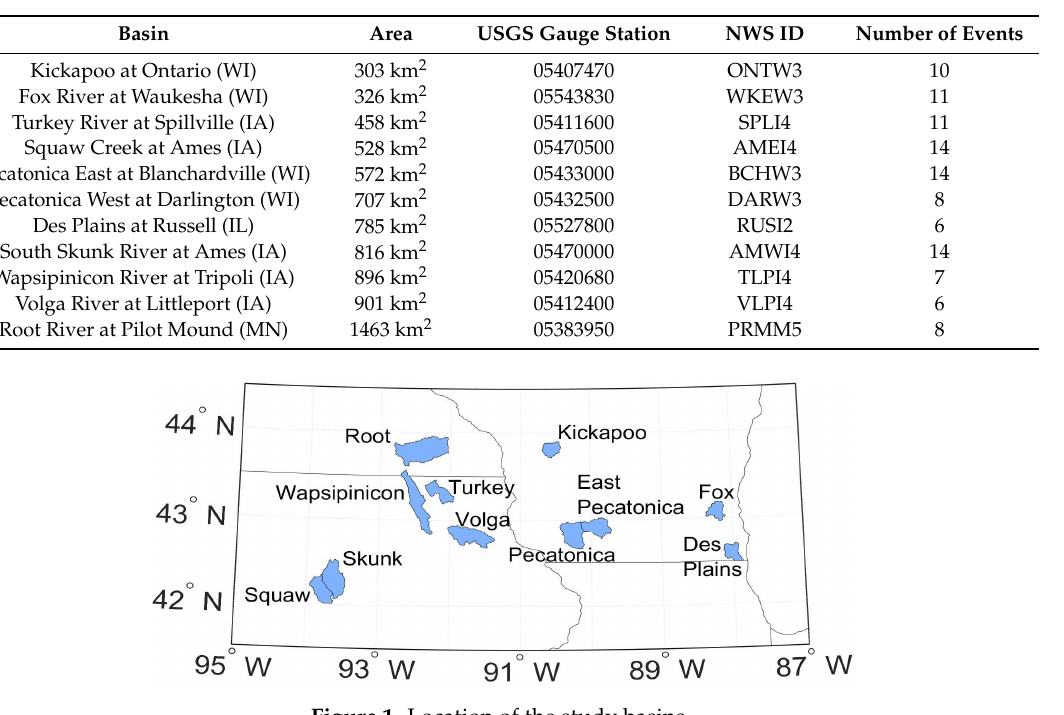
Figure 1. Location of the study basins.